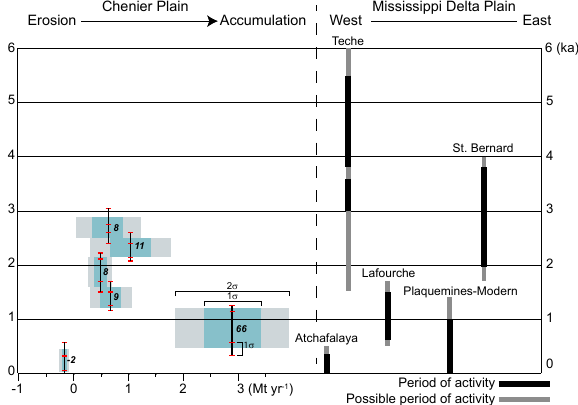
Figure 14. Accumulation patterns for the Chenier Plain with the chronology and the relative position of subdeltas in the Mississippi Delta plain during the past 6kyr. The numbers next to the vertical error bar of the accumulation rates show the relative contribution to the total accumulation for each period of accumulation. The vertical error bars are derived from the inferred ages in Table S2, while the horizontal error bars account for the uncertainty in the accumulation rate due to age uncertainties.